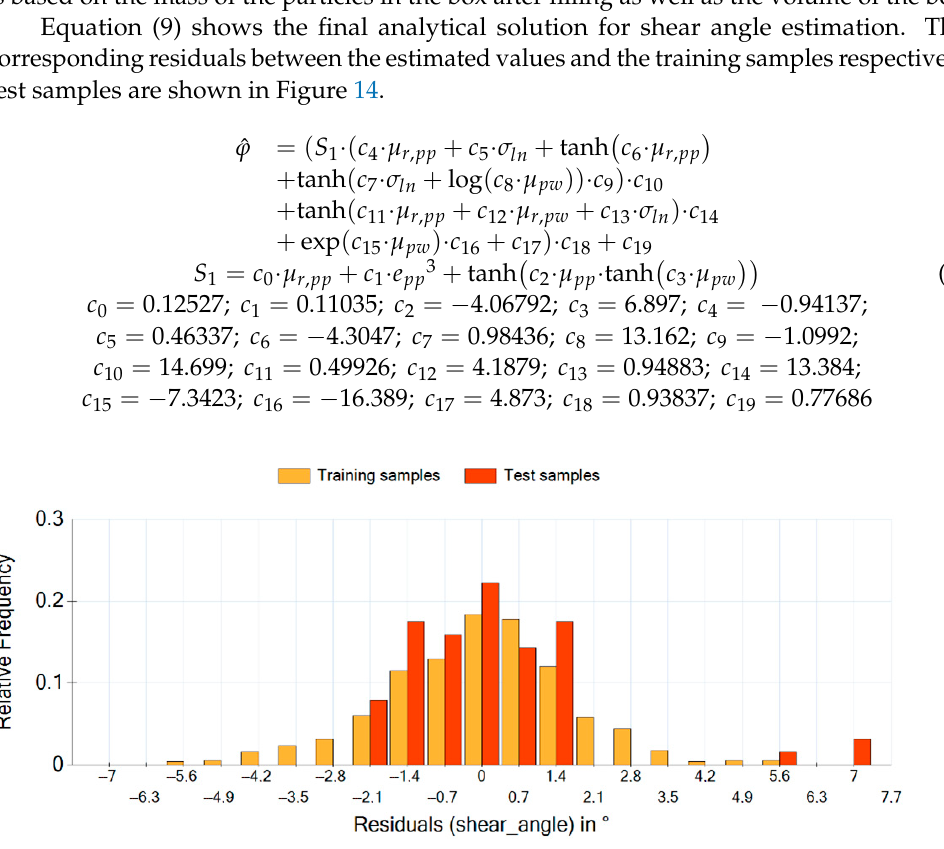
Figure 14. Residual Histogram for shear angle estimation.